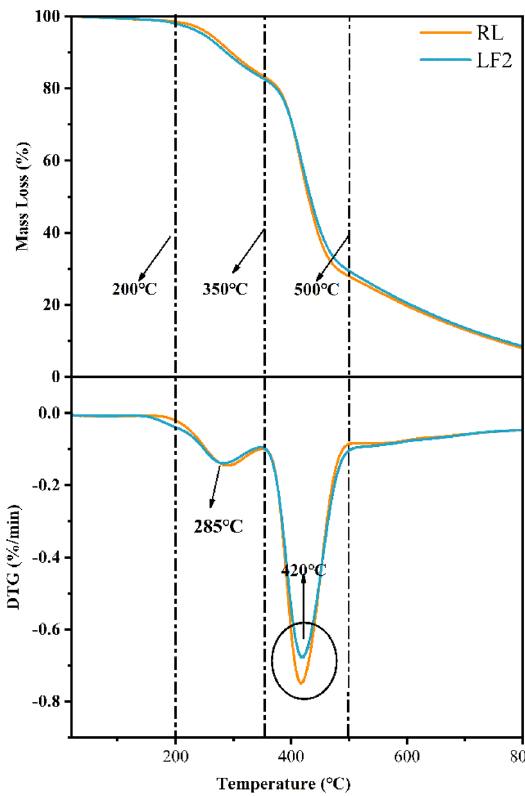
Figure 5. The TG-DTG curves of RL and LF2 with 10 K/min.